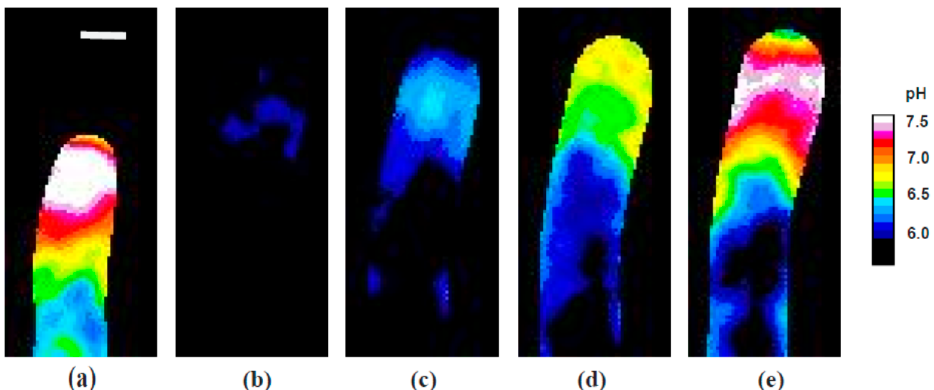
Figure 6. pH; Individual frames from a representative time-lapse video illustrating the dynamics of the alkaline band in response to KCN treatment, revealed by, 2',7'-bis-(2-carboxyethyl)-5-(and-6)- carboxyfluorescein (BCECF)-dextran fluorescence ratios: ( a ) pre-KCN condition; ( b ) minimal signals indicating uniform acidification of the cell to about 6.0 as growth reaches a minimum; ( c ) proton levels begin to decline in the region that will become the alkaline band; ( d ) alkalinization at the tip; ( e ) re-establishment of the acidic tip and alkaline band, just prior to the onset of increased growth rates. Bar in ( a ) corresponds to 10 µm.